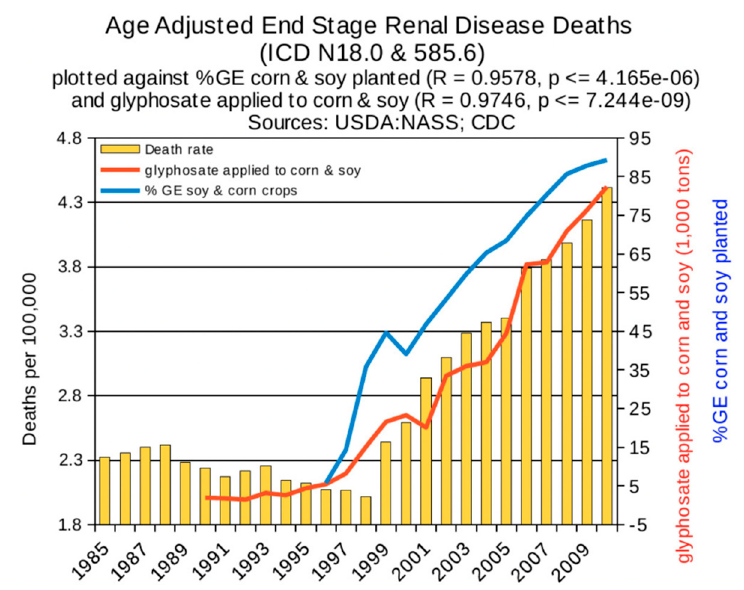
Figure 2. Correlation between age-adjusted End Stage Renal Disease deaths and glyphosate applications and percentage of US corn and soy crops that are GE. (From Swanson et al., 2014) [61].